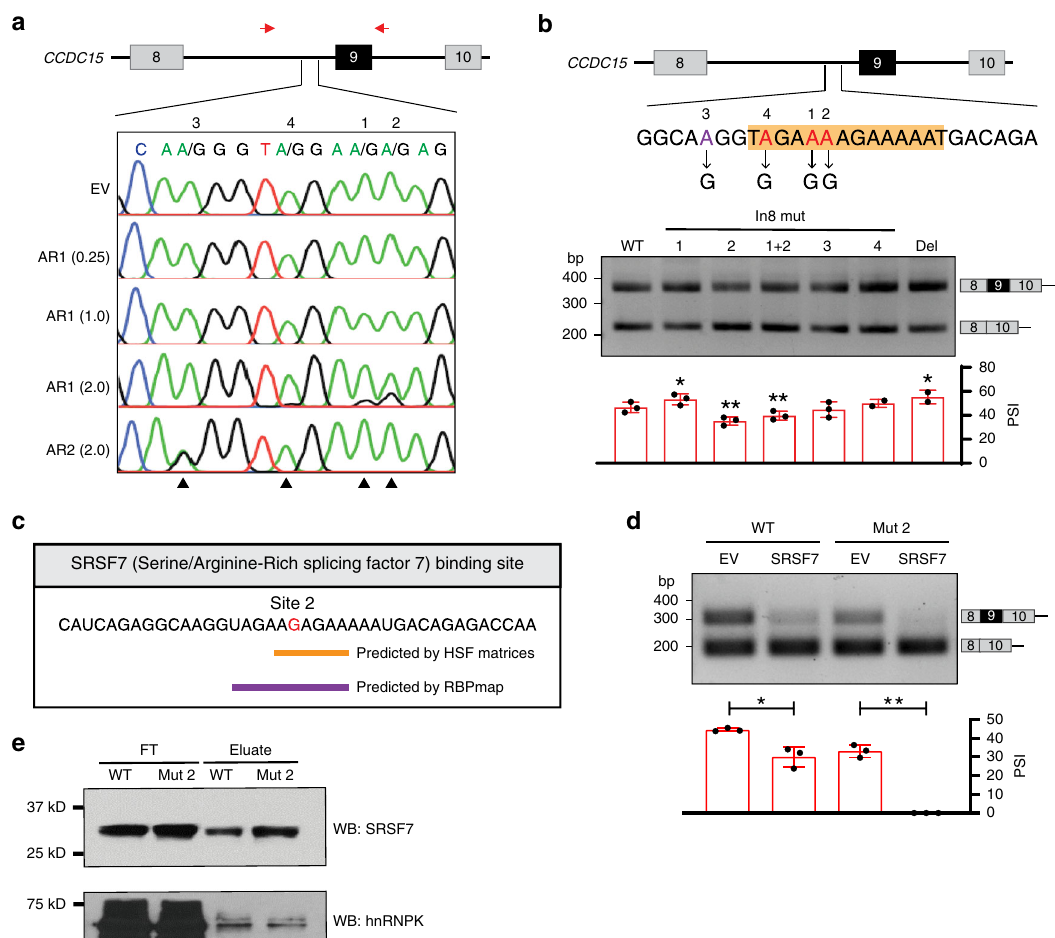
Fig. 3 ADAR1-mediated editing of an ISS enhances SRSF7 binding for exon skipping. a Sequence chromatograms illustrate the editing level of the indicated sites (1 – 4) at intron 8 of CCDC15 pre-mRNA in HEK293T cells that were transfected with empty vector control (EV), ADAR1 (0.25, 1.0, or 2.0 µ g), or ADAR2 (2.0 µ g) expression construct. Black arrowhead indicates editing position. Red arrows show the location of primers used for PCR ampli fi cation. b Upper panel: schematic diagram of wild-type (WT) CCDC15 exon 8 – 9 – 10 minigene. The positions where an A-to-G mutation was introduced are highlighted in red (sites 1, 2, and 4) and purple (site 3). The 13-bp region deleted in the Del minigene is shaded in orange. Lower panel: RT-PCR analysis of exon 9 inclusion of exogenous CCDC15 transcripts in HEK293T cells that were transfected with the indicated WT or mutant minigenes ( n = 3 or 2 biological replicates for each). 1 + 2 denotes both sites 1 and 2 were mutated from A to G. c In silico prediction of SRSF7 binding sites on the edited CCDC15 pre- mRNA by Human Splicing Finder (orange line) and RBPmap (blue line). The edited nucleotide at site 2 is highlighted in red. d RT-PCR analysis of exon 9 inclusion of exogenous CCDC15 transcripts in HEK293T cells that were co-transfected with WT or site 2-mutated (Mut 2) minigene together with EV or SRSF7 expression construct ( n = 3 biological replicates for each). e WB analysis of RNA pulldown products (eluate) shows binding of SRSF7 and hnRNPK protein to the WT or Mut 2 RNA probes. Sequence of the Mut 2 probe is shown in c and the WT probe is the same except site 2 that remains as an unedited adenosine. FT, fl ow-through. b , d Data are presented as the mean ± S.D. of percent spliced in (PSI) values from biological replicates. Each dot represents a biological replicate. Statistical signi fi cance is determined by paired t -test (* P < 0.05; ** P < 0.01). Source data are provided as a Source Data fi